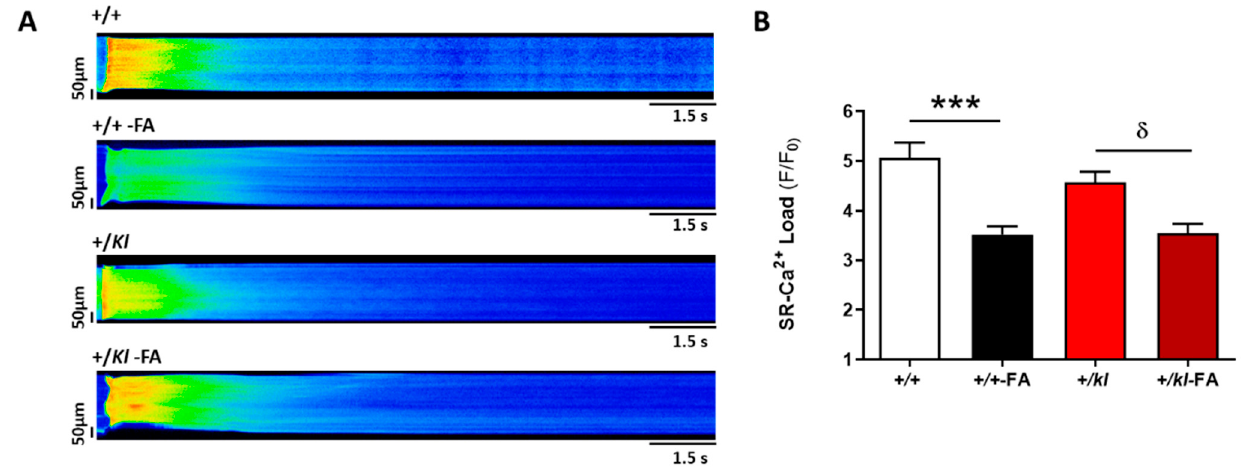
Figure 3. AKI decreases SR-Ca 2+ load in adult ventricular cardiomyocytes independently of the klotho expression. ( A ) Representative line-scan images of caffeine-evoked Ca 2+ transients in cardio- myocytes from each experimental group obtained by confocal microscopy. ( B ) Mean values of Ca 2+ transient amplitude evoked by caffeine (peak fluorescence Ca 2+ , F/F 0 ) in cardiomyocytes from +/+ (n = 24 cells, N = 5 mice), +/+-FA (n = 39 cells, N = 4 mice), +/ kl (n = 27 cells, N = 5 mice) and +/ kl -FA mice (n = 25 cells, N = 3 mice). Data are expressed as mean ± SEM. *** p < 0.001 vs. +/+, δ p < 0.05 vs. +/ kl .